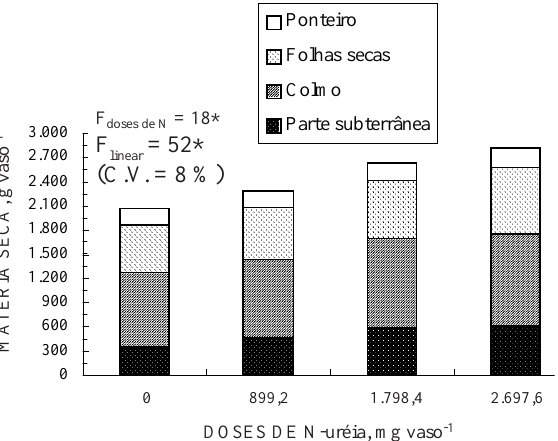
Figura 2. Produção de matéria seca na cana-planta em relação às doses de N-uréia aplicadas no plantio (os valores de teste F e de C.V. referem- se à planta